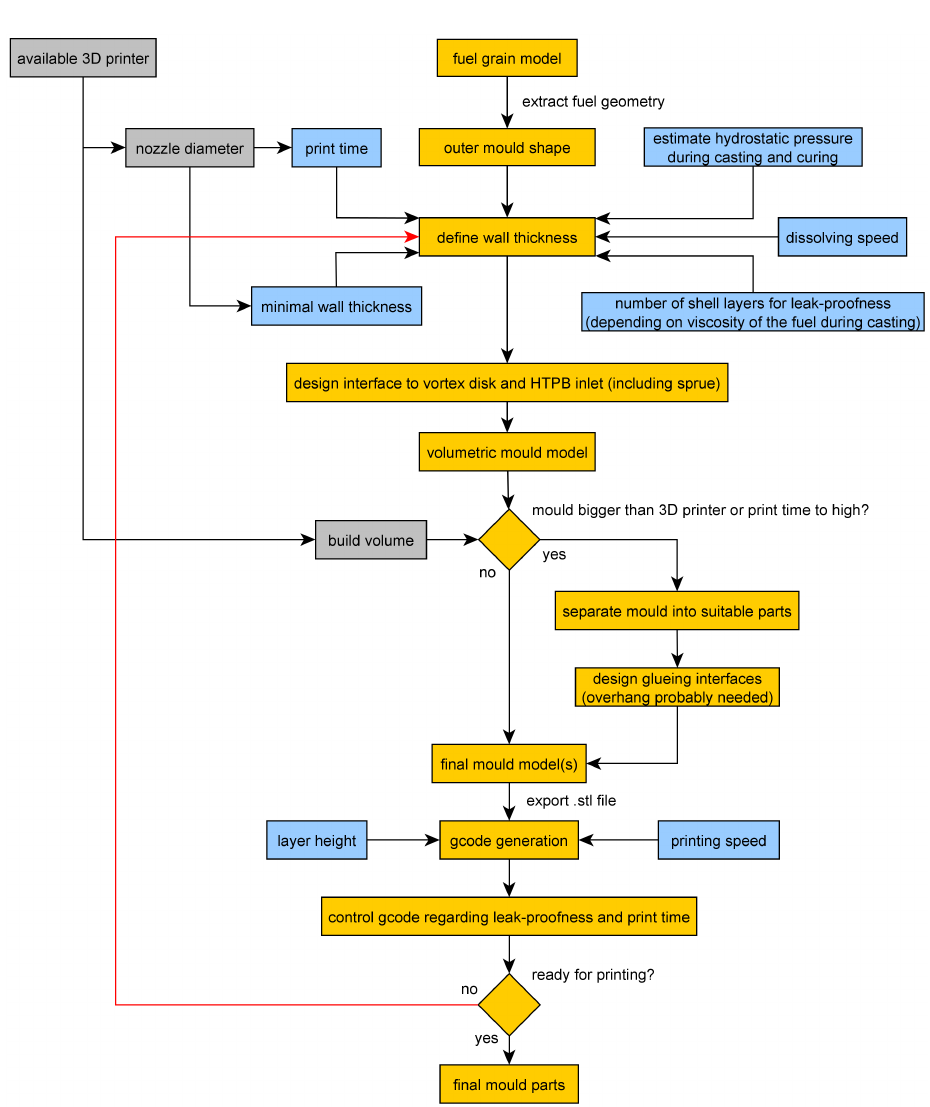
Figure A1. The flow chart of the mold design